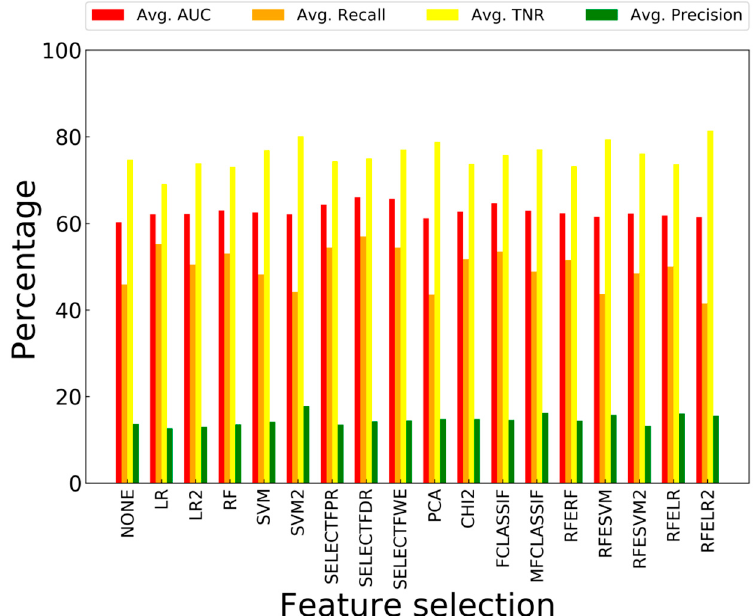
Figure 9. Average performance of each feature selection approach on balanced data.